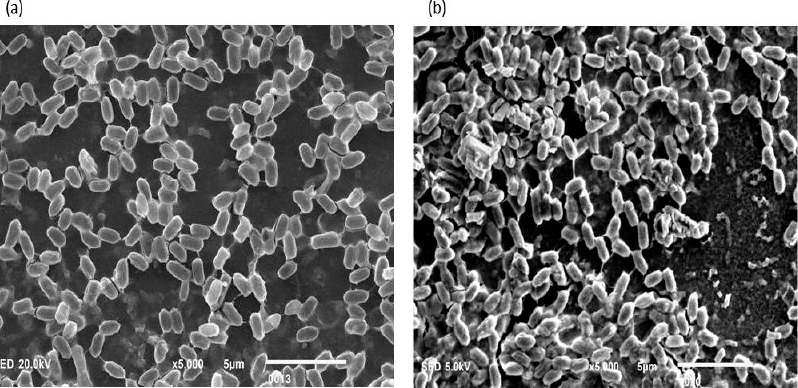
Figure 1. ( a , b ): Biofilm-positive cells occupying the lower base of biofilm consortia and adhered to the glass surface. The weight was not applied to these cells. Therefore, the cells maintained a typical P. aeruginosa shape (Rod shape). The majority of cells are scattered and connected side by side. However, a small population is also connected through nanotubes.